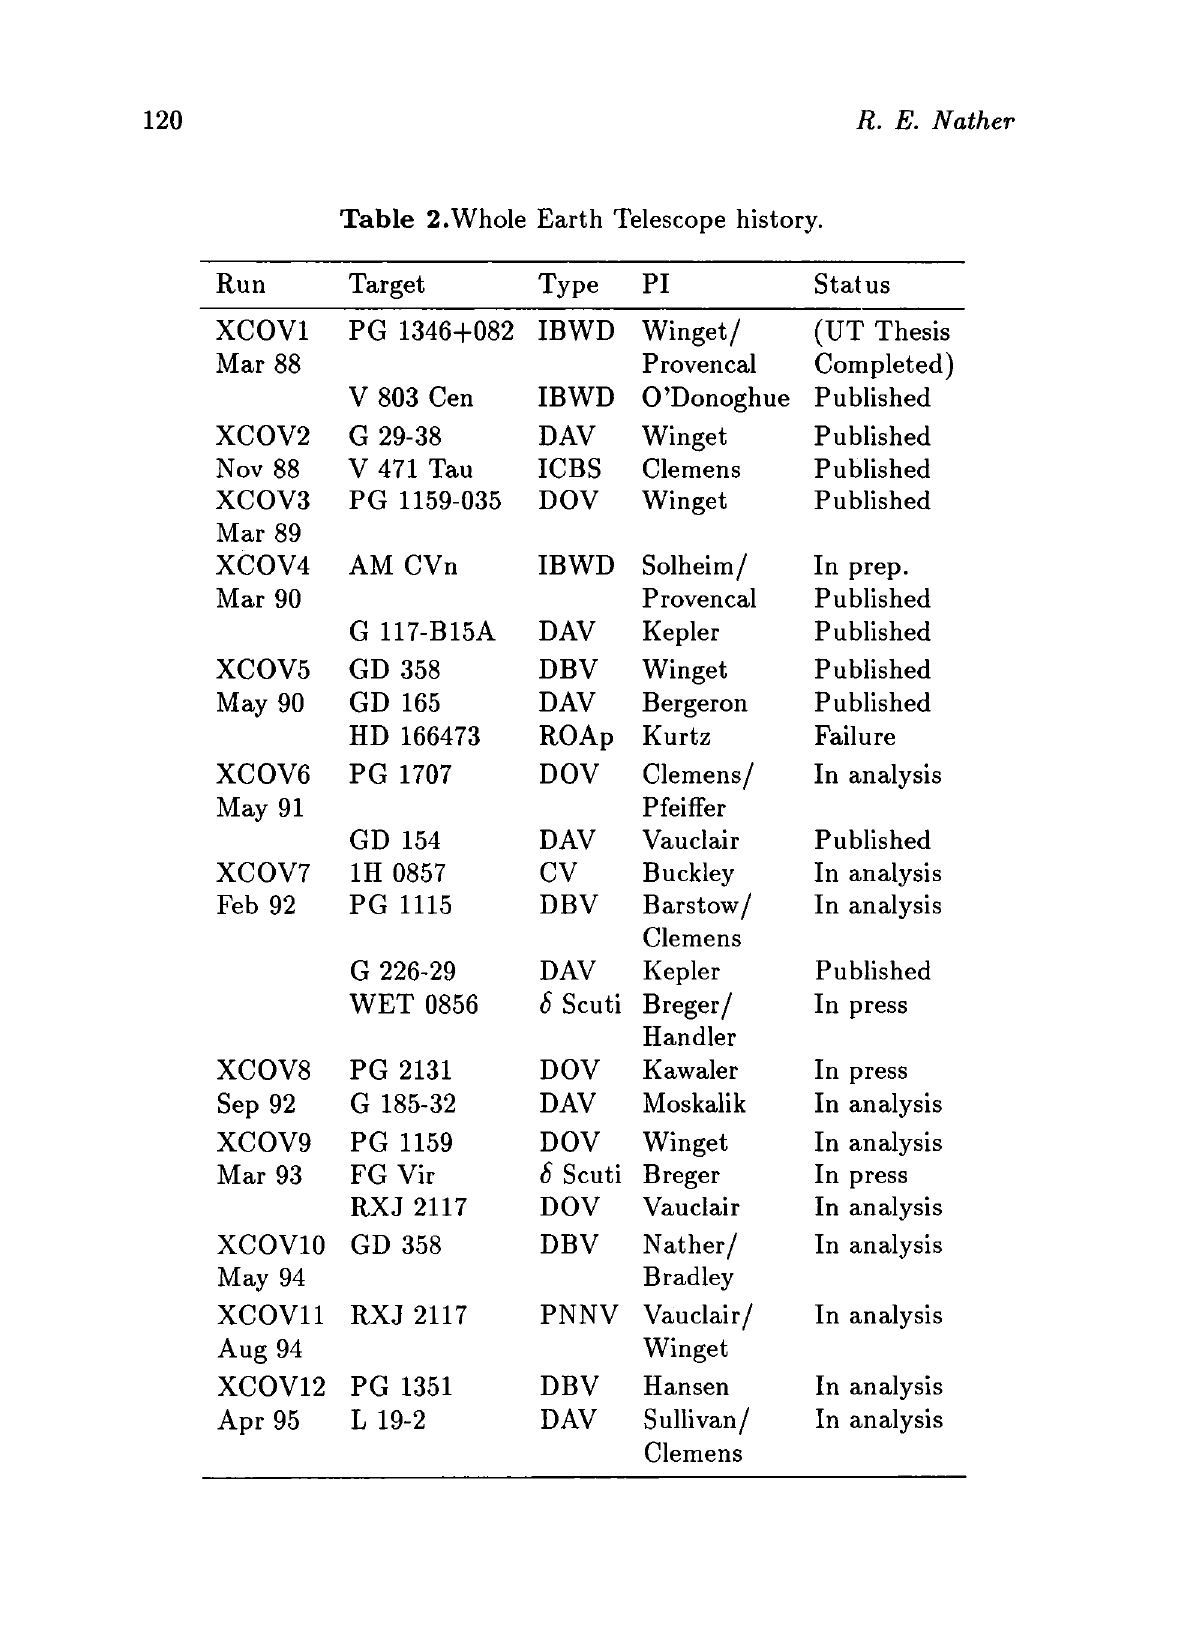
Table 2. Whole Earth Telescope